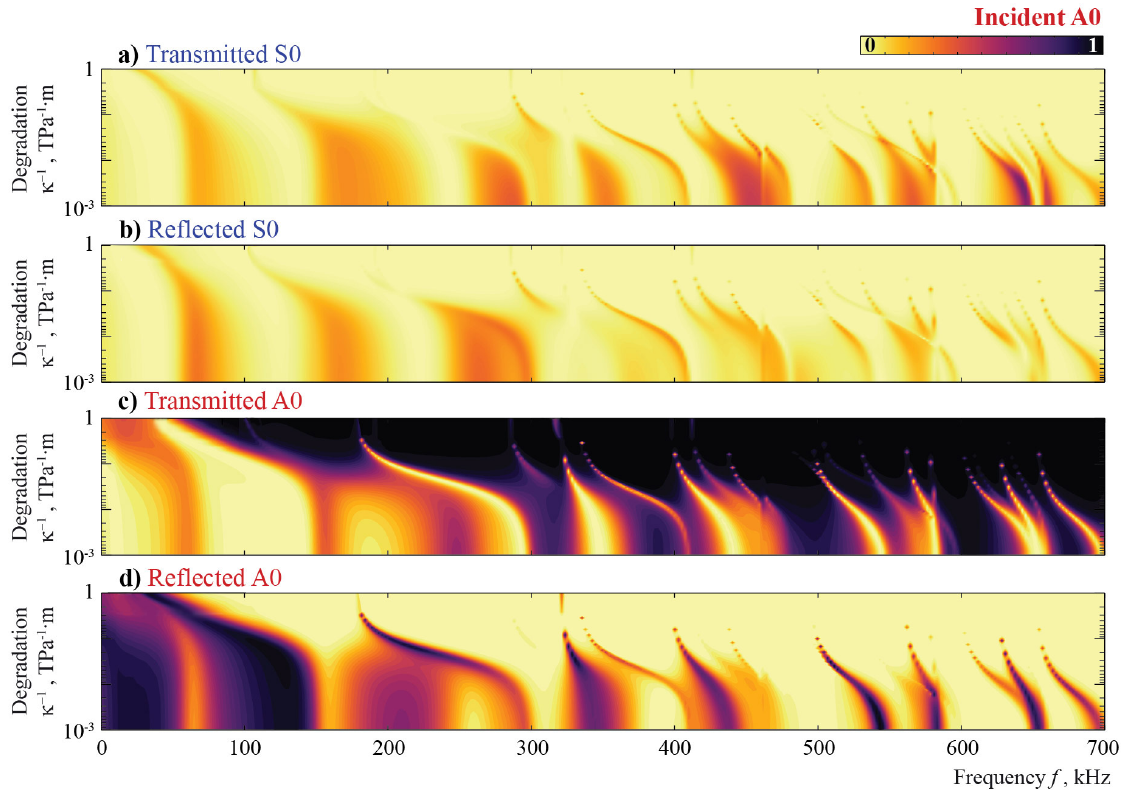
Figure 14. The transmission and reflection coefficients β ± m ( f , κ − 1 ) for the incident A0 mode scattered by an obstacle with a